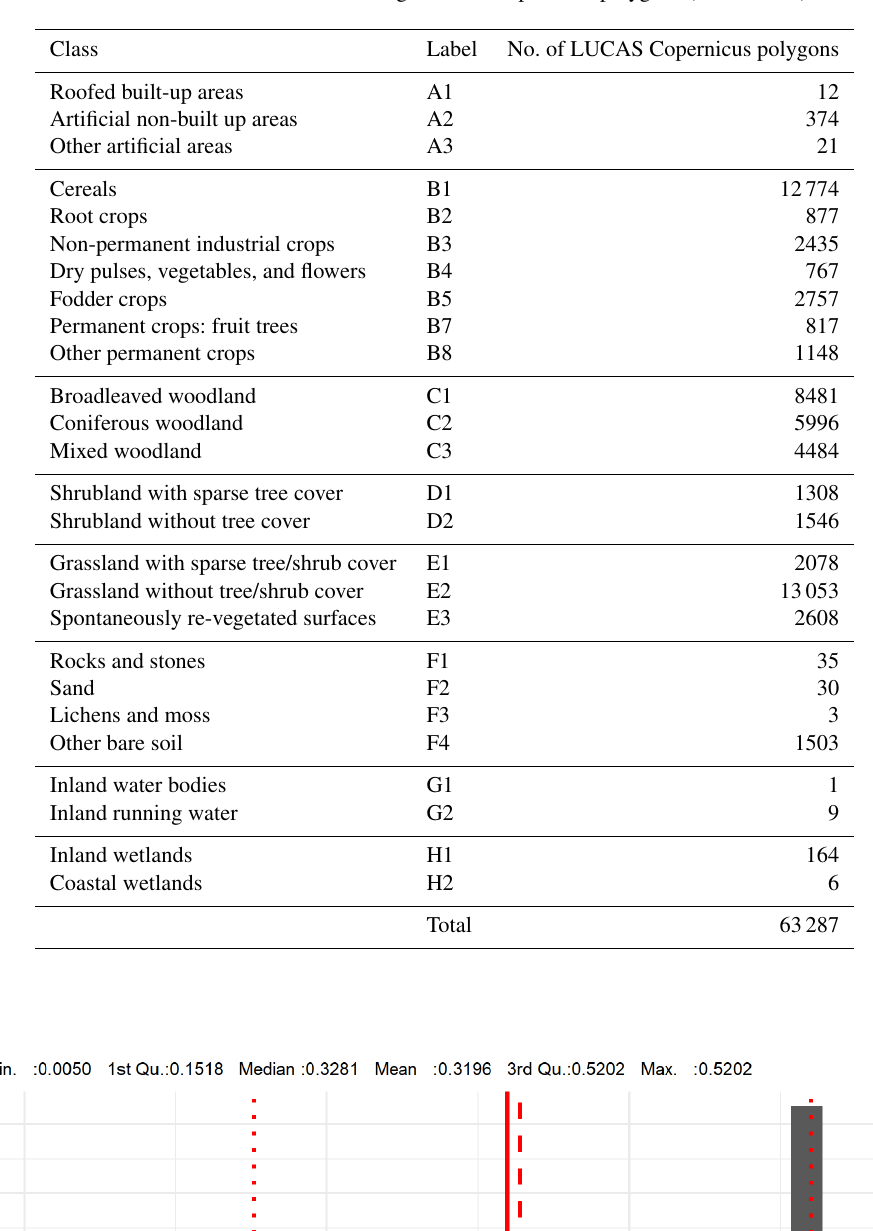
Table 3. Distribution of level-2 land cover classes of the resulting LUCAS Copernicus polygons ( N = 63287).